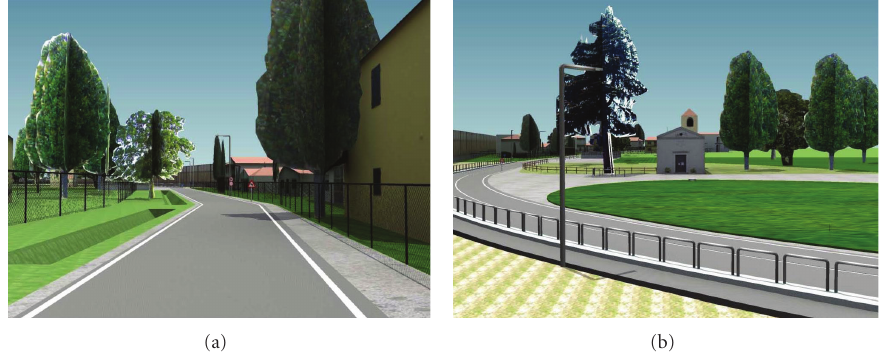
Figure 1: Details of the virtual environment.